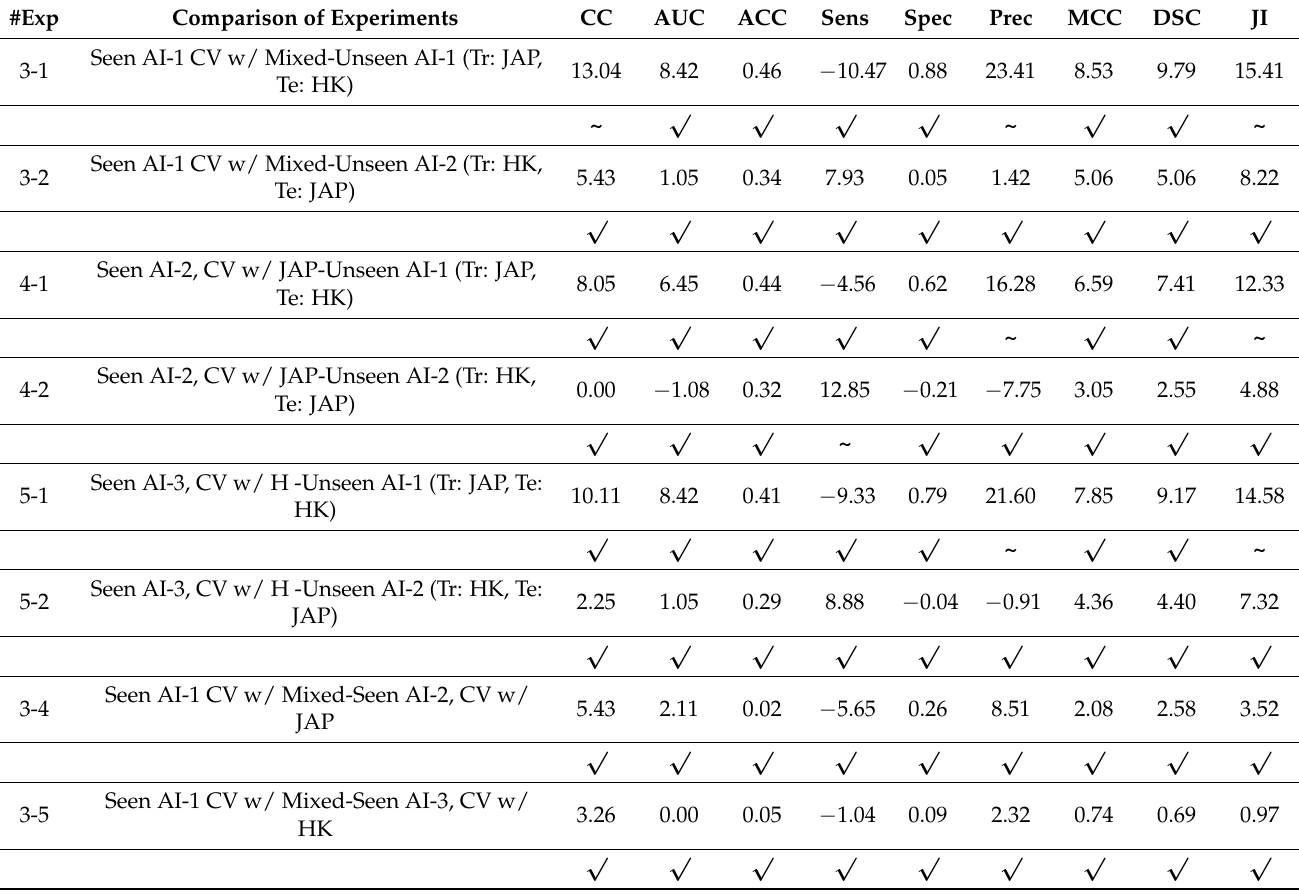
Figure 11. Comparison of ROC curve for unseen and seen database experiments. Table 4. Comparison of experiments and validation of hypothesis.